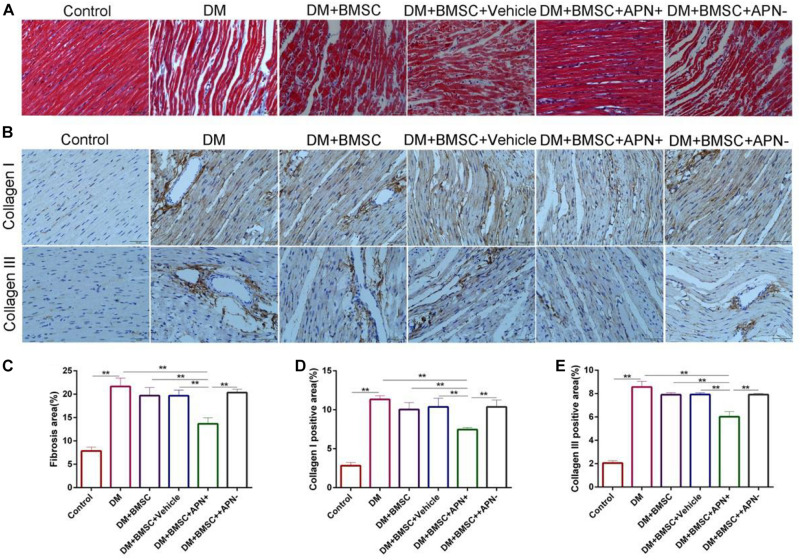
Effect of APN on collagen deposition. (A) Representative Masson’s trichrome staining. (B) Immunostaining of collagen I and collagen III. (C) Quantitative analysis of Masson’s trichrome staining. (D) Immunohistochemistry analysis of collagens I. (E) Immunohistochemistry analysis of collagens III. Data are mean ± SD; *p < 0.05, **p < 0.01.